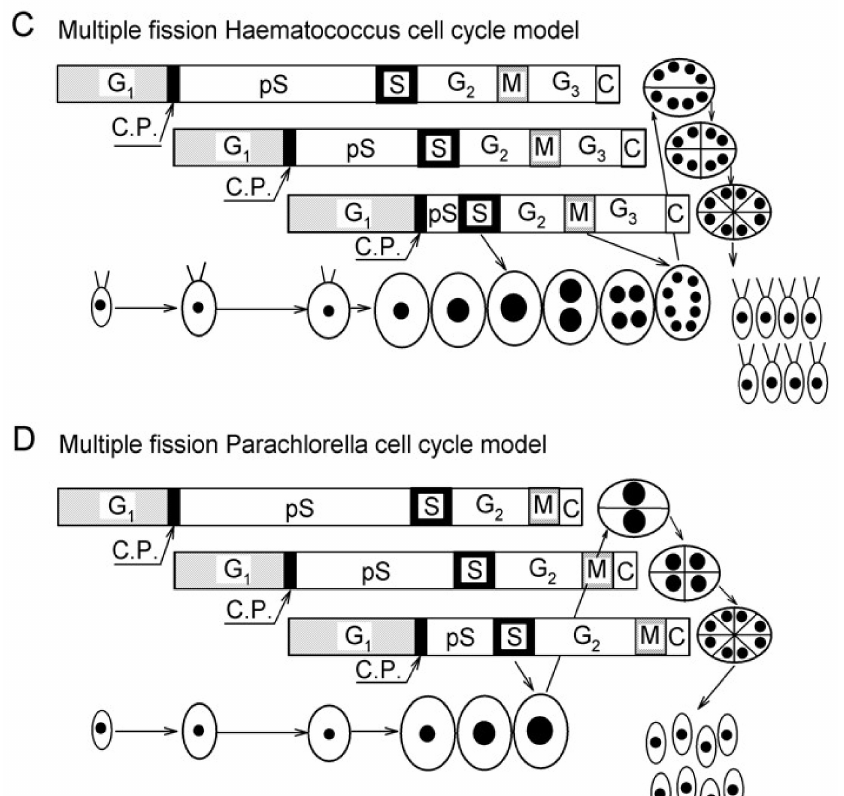
Figure 10. Schematic diagram of growth and the cell cycle in a single cell of different algae dividing into 8 daughter cells. ( A ): Desmodesmus ( Scenedesmus ) quadricauda , ( B ): Chlamydomonas reinhardtii , ( C ): Haematococcus pluvialis, ( D ): Parachlorella kessleri . The schematic pictures reflect increasing cell size. The full circles inside the cells illustrate the size and number of nuclei. Larger circles indicate a doubling of DNA. Ellipsoids and lines represent protoplast division. Three bars indicate three overlapping growth and reproductive sequences terminated by division into 2, 4, and 8 daughter cells, respectively. Pre-commitment period (G1): the period until threshold critical cell size for commitment to divide (CP) is reached and CP is attained. Post-commitment period consists of pS—the pre-replication phase between CP attainment and the beginning of DNA replication. The processes required for initiation of DNA replication are assumed to happen during this phase. S: DNA replication takes place. G2: the phase between the termination of DNA replication and the start of mitosis (M). Processes leading to the initiation of mitosis are assumed to take place during this phase. G3: the phase separating mitosis from cellular division, which is clearly visible in some algae dividing by multiple fission. The processes leading to cellular division are assumed to take place during this phase. C: the phase during which cell cleavage (protoplast fission) and daughter cell formation occurs. Modified after Zachleder, Schläfli and Boschetti [6], Zachleder and van den Ende [8], Reinecke, Castillo-Flores, Boussiba and Zarka [54] and Zachleder, Bišov á and V í tov á